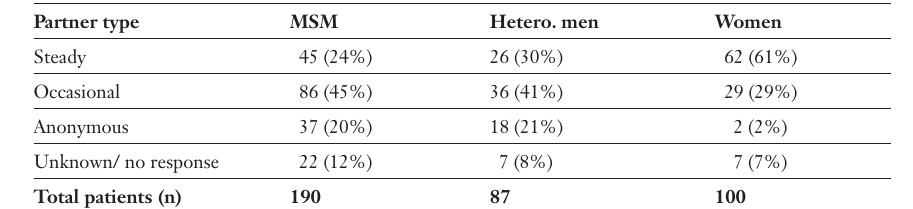
Unprotected sexual contact as a source of HIV infection and dis- tribution of partner type(s) (steady, occa- sional, anonymous, unknown/no re- sponse) as indicated by patients on the